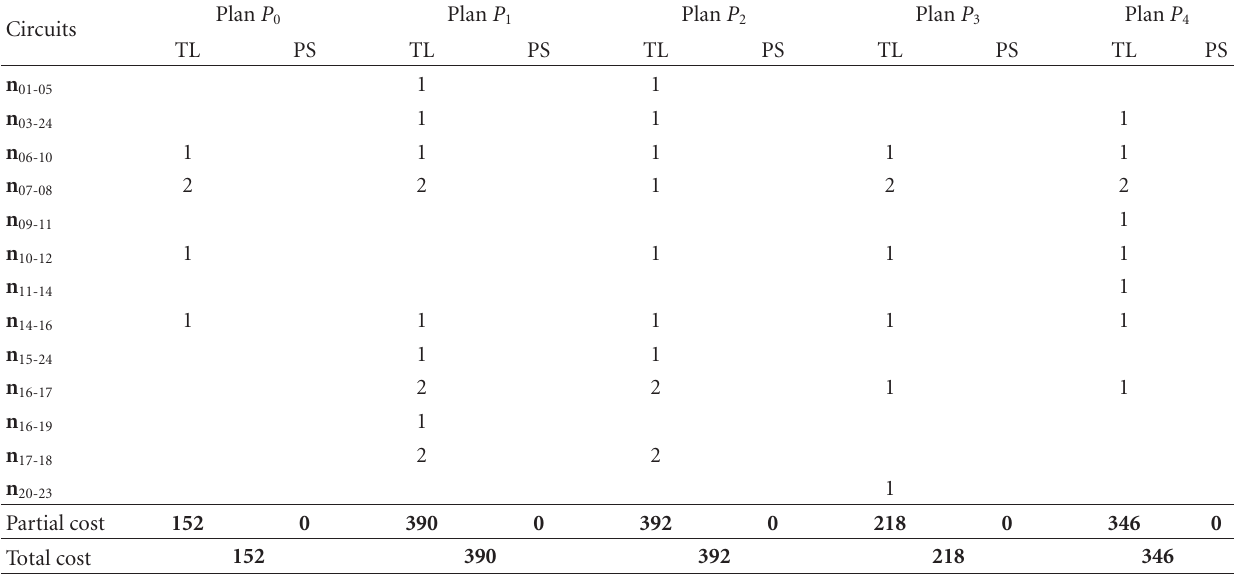
Table 4: Five transmission expansion plans considering high-cost phase-shifter transformers.